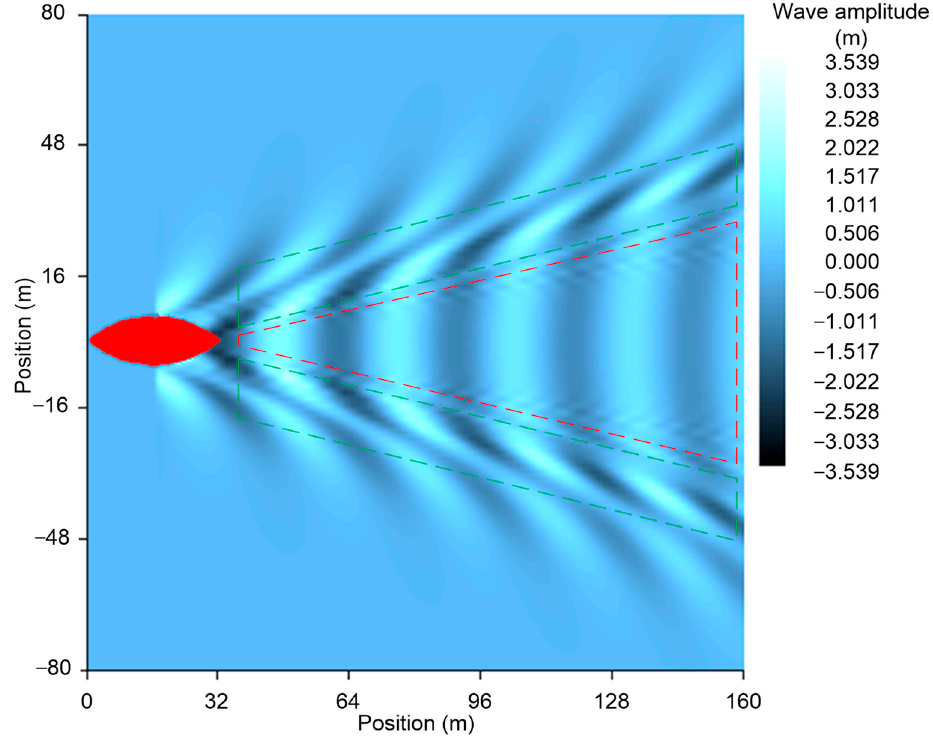
Figure 4. Waves forming behind the stern of a moving tugboat. Transverse waves marked with a red outline, divergent waves marked with a green outline.